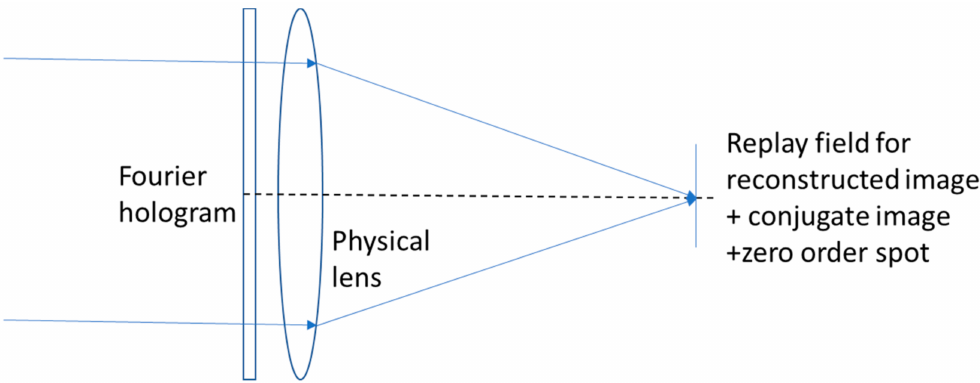
Figure 2. Fourier hologram with a physical